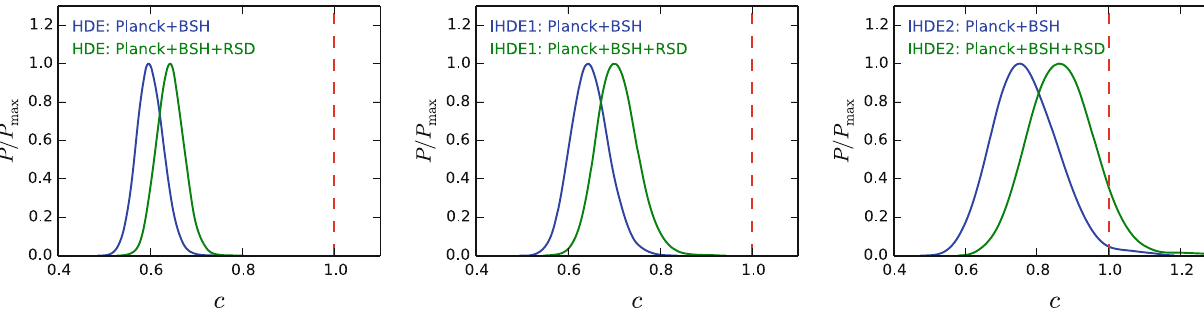
Fig. 2 The one-dimensional posterior distributions of c for the HDE ( Q = 0), IHDE1 ( Q = β H ρ c ), and IHDE2 ( Q = β H 0 ρ c ) models by using the Planck+BSH and Planck+BSH+RSD data